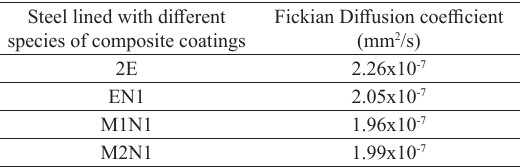
Table 2. Fickian Diffusion coefficient values of steel coated by epoxy and epoxy filled with micro/nano Al immersed in 3.5 wt%NaCl.